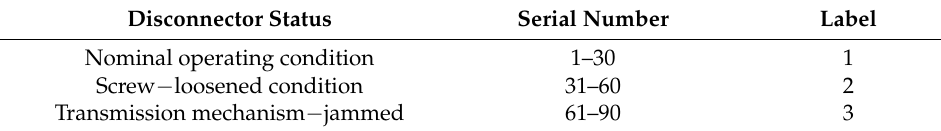
Table 3. Sample test set.